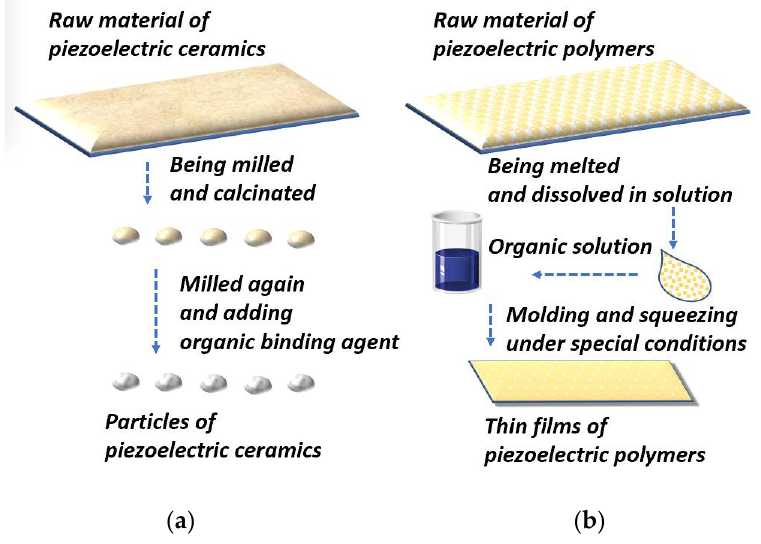
Figure 4. The fabricating mechanism of piezoelectric ceramics ( a ) and polymers ( b ). The key step of ceramics is milling into tiny size to achieve a more obvious piezoelectric effect [42,43]. While the key step of polymers is squeezing because its properties is decided in this stage [44,45].